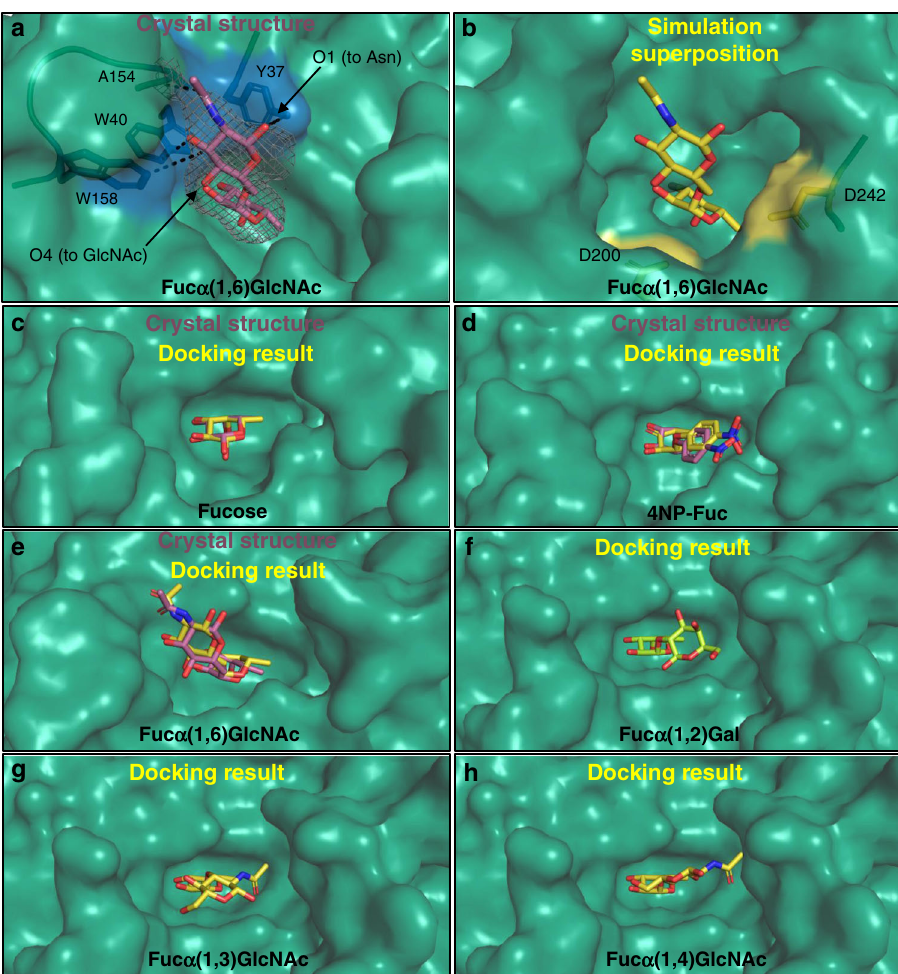
Fig. 5 Structural basis of AlfC α (1,6)-speci fi city. a Crystal structure of AlfC D200A with Fuc α (1,6)GlcNAc. The gray mesh represents a composite omit map of electron density surrounding the ligand, contoured to 1.5 σ , and carved to 2.2 Å. An aromatic pocket that accommodates the GlcNAc + 1 moiety is colored blue. b Superposition of Fuc α (1,6)GlcNAc crystal structure over the closed state from molecular dynamic simulation (Fig. 3e) depicts a well- accommodated substrate. c – e Molecular docking of AlfC ligands (yellow) compared to crystal structures (magenta). Accuracy of docking shown by structural comparisons of c fucose; d 4NP-Fuc; e Fuc α (1,6)GlcNAc. f – h Molecular docking results for inef fi cient substrates show + 1 moiety outside the aromatic pocket, near the D242 loop. f Result for Fuc α (1,2)Gal; g Fuc α (1,3)GlcNAc; and h Fuc α